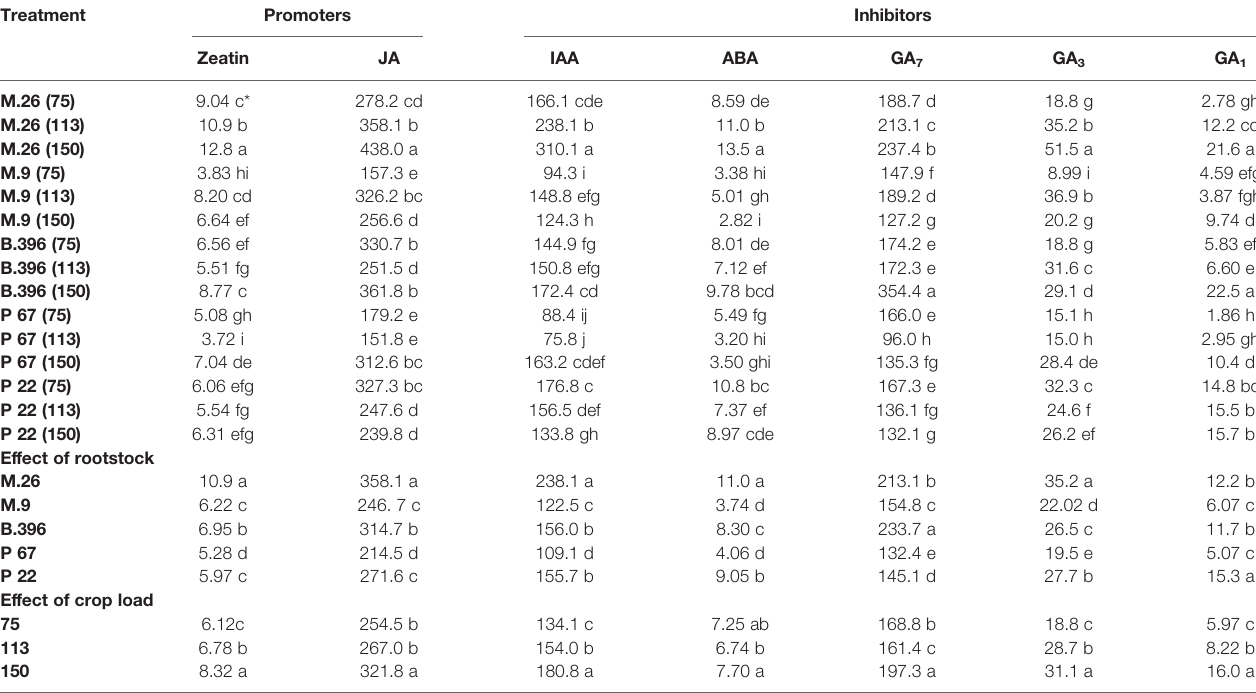
TABLE 4 | The effect of rootstock and crop load interaction on the accumulation of phytohormones in “ Auksis ” buds (ng g − 1 . FW). Treatment